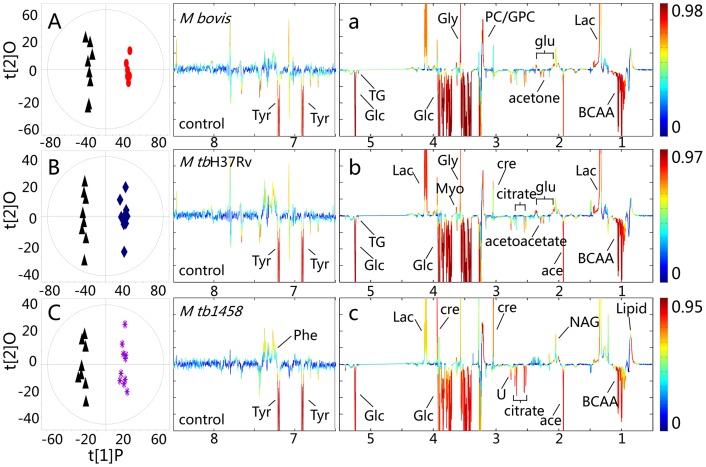
OPLSDA comparison of plasma spectra between the control and infected groups (M. bovis, M. tbH37Rv, and M. tb1458).In panels A, B, and C, the triangle (▴) represents the control, the black circle (•) represents M. bovisinfected group, the diamond (◊) represents the M. tbH37Rv-infected group, the asteric (*) represents the M. tb1458-infected group; In panels a, b, and c, the upward and downward peaks, respectively, denote the elevated and decreased metabolites in the infected calves with hot colored metabolites contributing more significantly to the class discrimination than the cold colored metabolites.